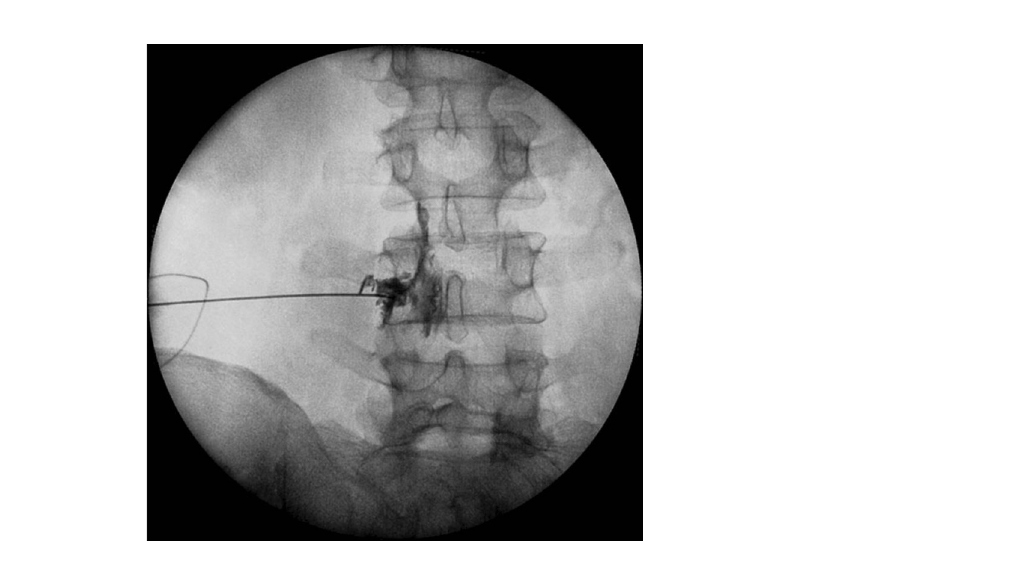
Figure 3. Fluoroscope verification of contrast spread at L4/L5.